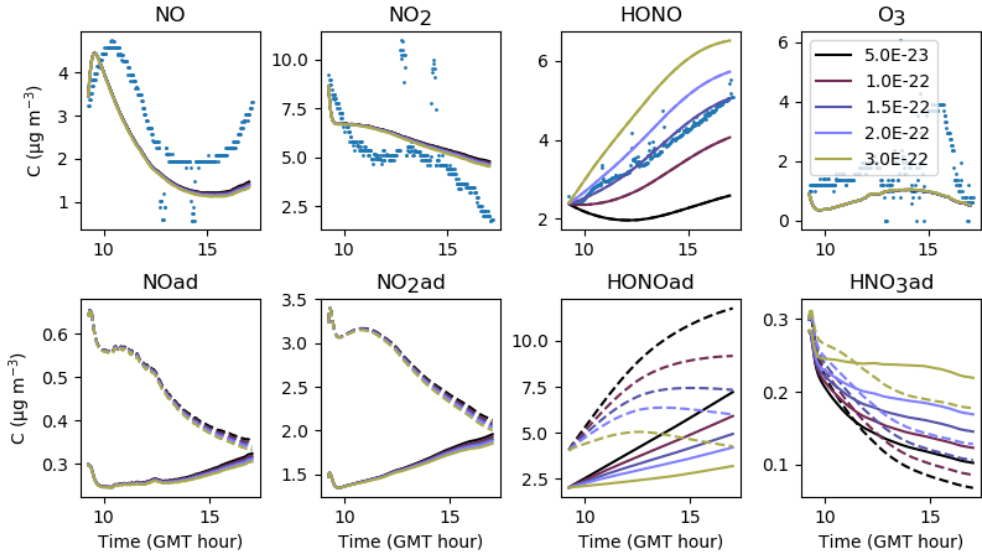
Figure 21. Gas-phase and adsorbed inorganic compounds simulated for different k (cid:48) surements (Experiment 3). The solid lines represent the concentrations in the sunlit box and the dashed lines the concentrations in the shaded box.